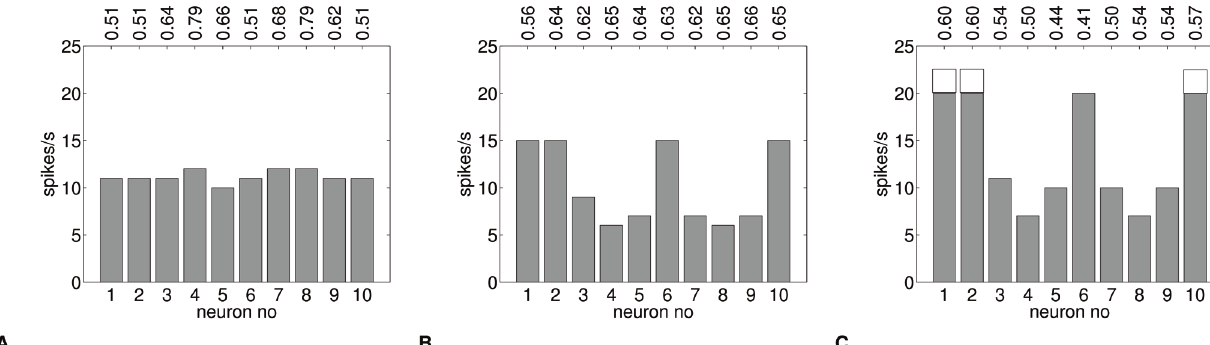
Figure 8. Negative pattern learning. Spike frequency histograms for 10 adaptive neurons ( θ =11.5Hz) ( A ) habituation for neurons adapted to P learn , ( B ) an inverse pattern for P learn -adapted neurons tested with P and ( C ) interference (dampening of response) for a new pattern noise P (naive: line-drawn bars, adaptive: filled bars). Average synaptic input (nA/cm 2 ) for each neuron is shown on top. ( A ) shows a uniform test response to patterend synaptic input and ( B ) a patterned response to uniform (noise) input. ( C ) shows a difference of response for naive vs. P learn -adapted neurons to a new pattern P test